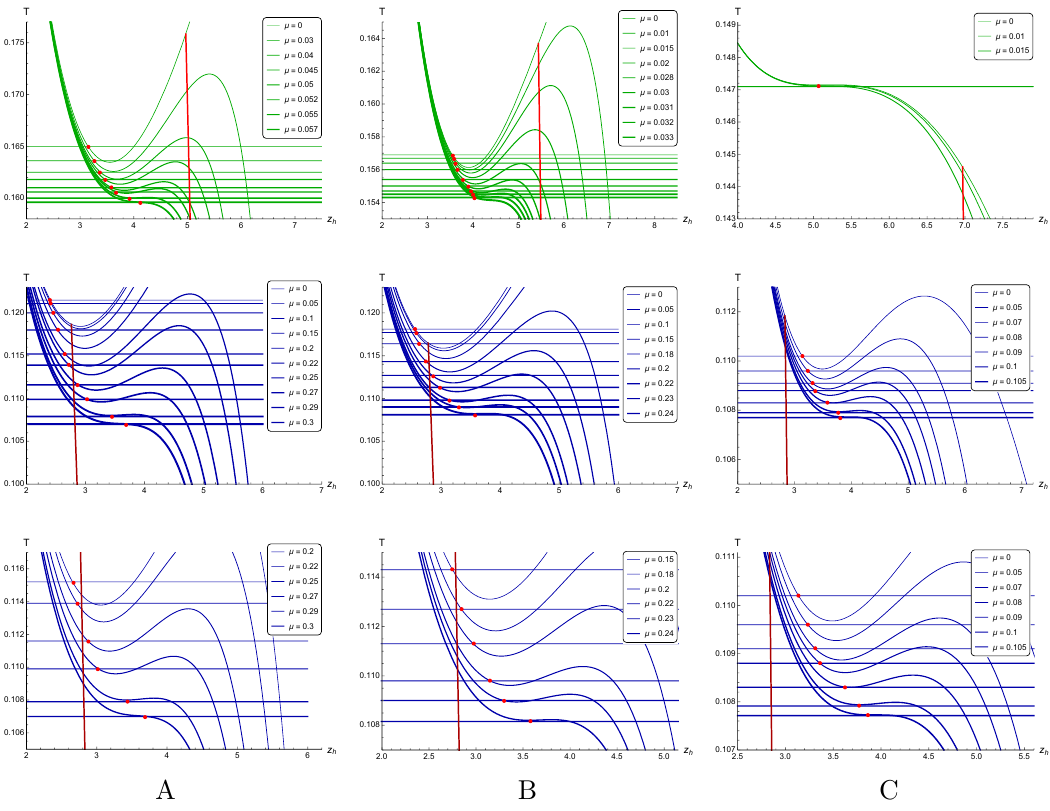
Figure 15 . Location of the BH-BH phase transition points (red point) relative to the dynamic wall (red lines) for ν = 1 (first line) and ν = 4 . 5 (second and third line, third line is the zoom of the second) for c B = 0 (A), c B = − 0 . 005 (B), c B = − 0 . 0096 for ν = 1 and c B = − 0 . 015 for ν = 4 . 5 , c = 0 . 227 . T is in units of GeV and z h of GeV − 1